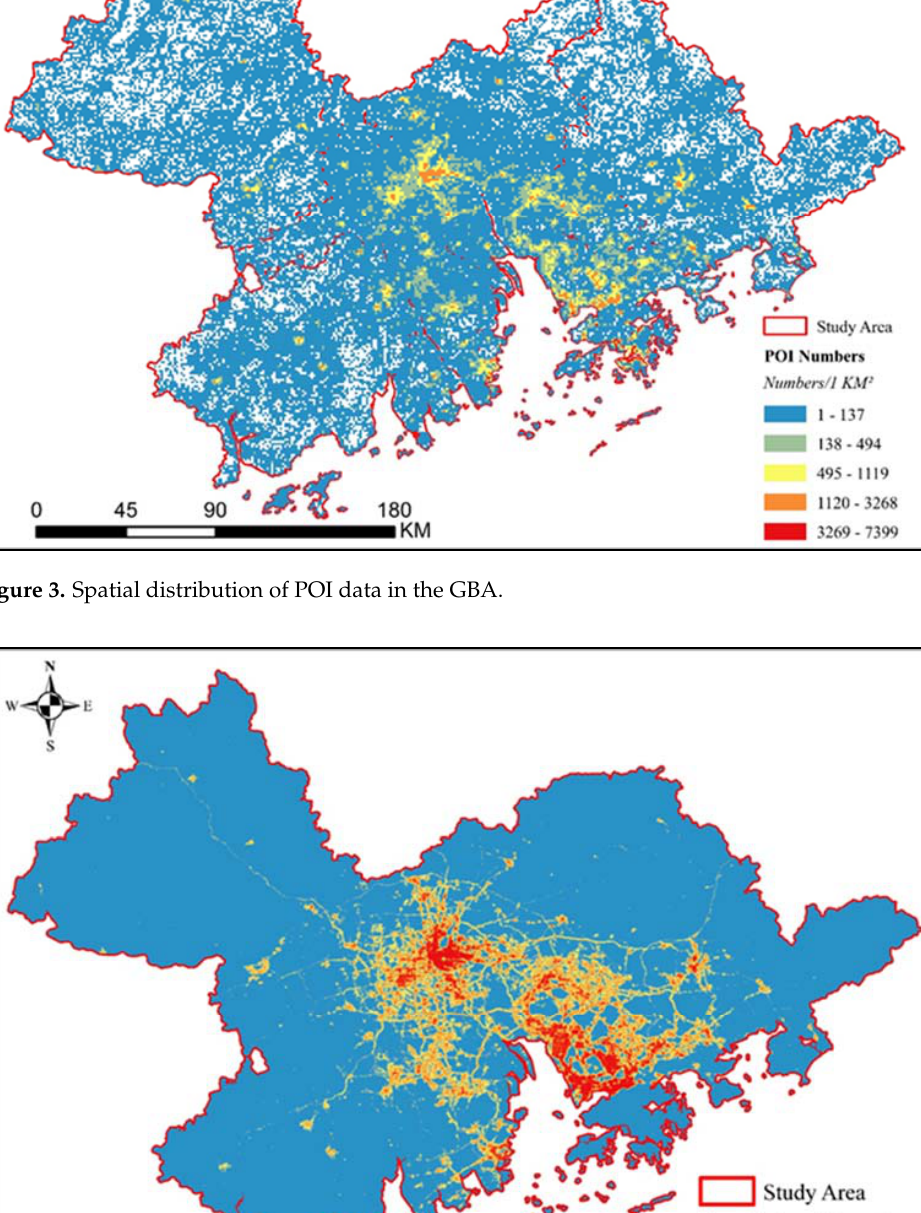
Figure 4. Preprocessing result of population migration data.